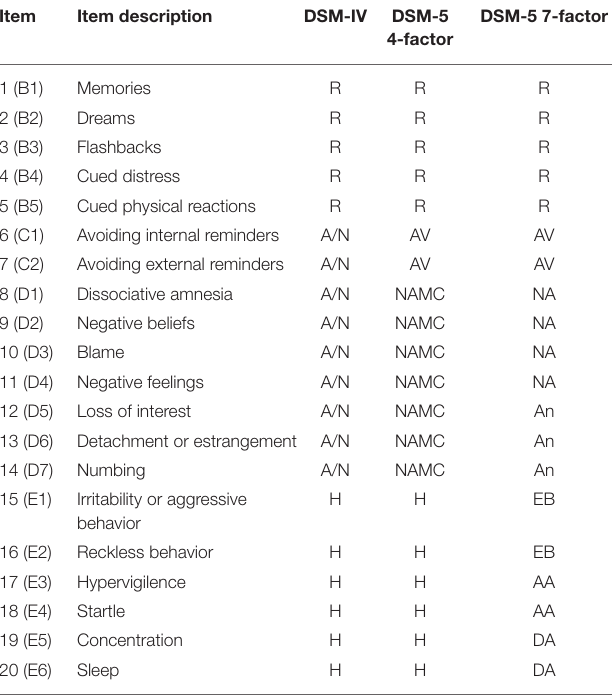
TABLE 2 | Item mapping for different factorial models for the PCL.